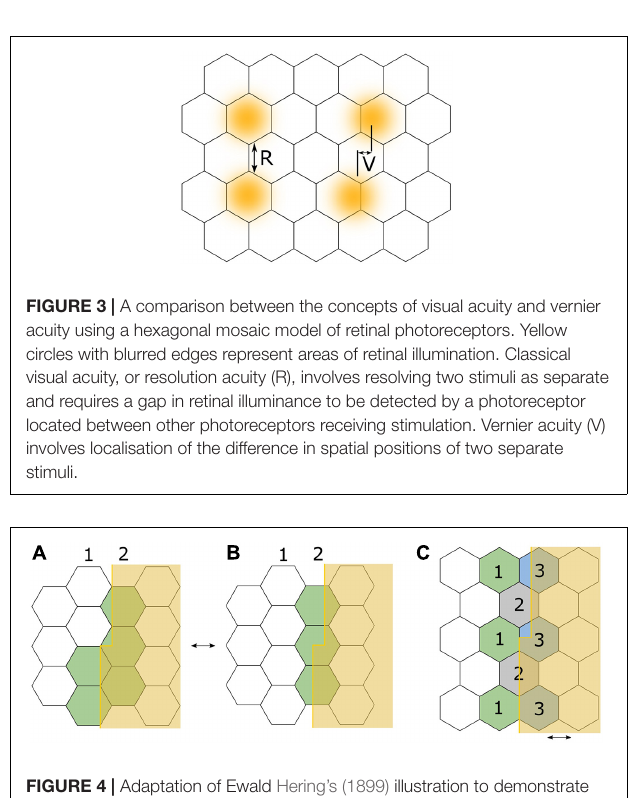
FIGURE 4 | Adaptation of Ewald Hering’s (1899) illustration to demonstrate his eye-movement hypothesis for detection of a small vernier offset, using a hexagonal retinal receptor mosaic model. Each receptor corresponds to an all-or-none “local sign” or “space value.” (A) The offset edge lies along two lines of receptors, with the top half exciting only line 2, and bottom half exciting both lines 1 and 2. Excitation is depicted in green. (B) The offset edge completely falls along a single line of receptors (line 2) and is therefore perceived as “straight.” Small, repetitive eye movements between (A,B) would provide the location difference of the offset lines via higher order averaging (Strasburger et al., 2018). (C) In a different orientation, an offset edge lies parallel to the boundaries between receptors. With minute horizontal eye movements across the arrangement, receptors marked 1 and 2 contribute to the location signal of the lower half, and receptors marked 2 and 3 contribute to the location signal of the upper half, thus leading to differential excitation along the edge. Note that on the retinal surface, the edge will not be so sharply demarcated as in this figure; diffraction will result in a steep gradient of